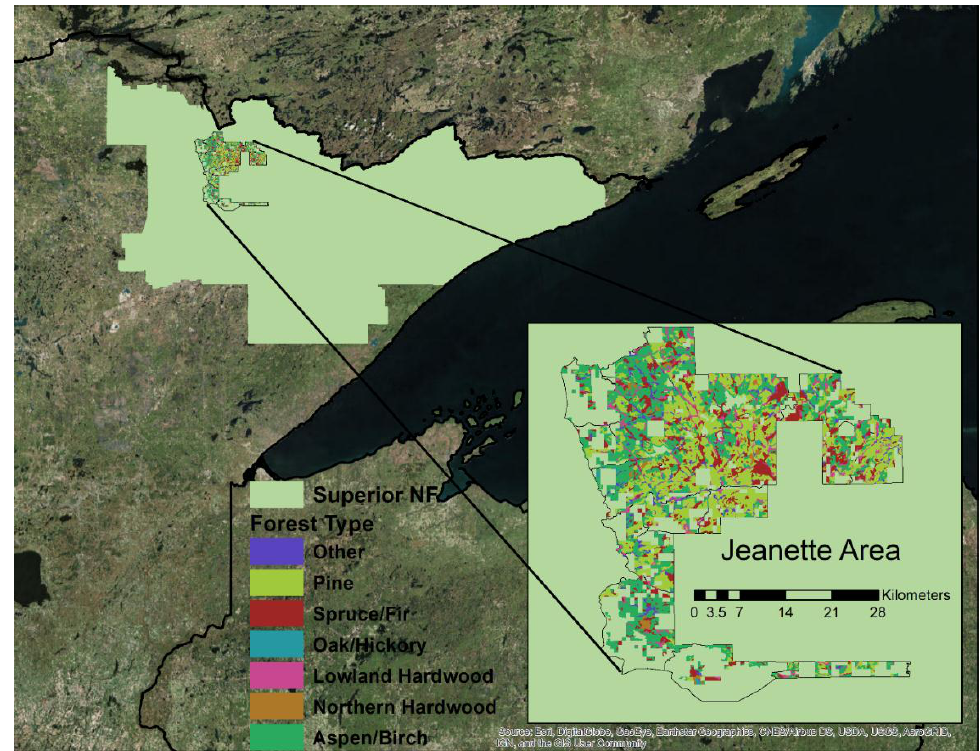
Figure 1. Location of Superior National Forest and Jeanette Project Area, with forest types, in northeastern Minnesota, USA.